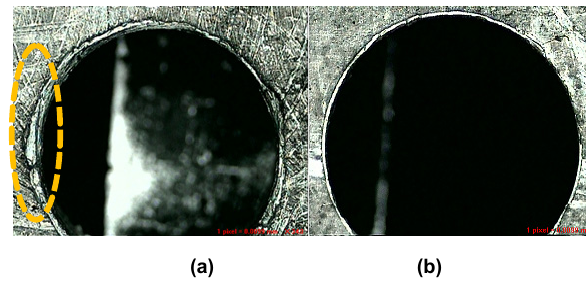
Figure 11. VMM images of holes “entrance” surface; (a) CD and (b) UAD. (SiC content= 1 %wt; feed rate= 20 mm/min;